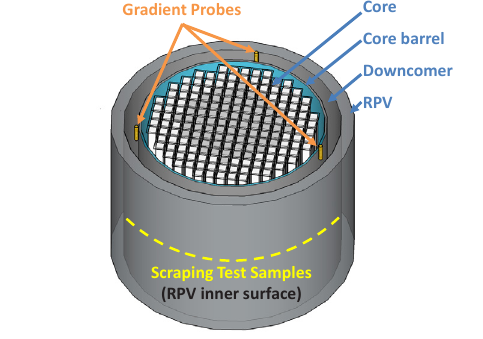
Figure 1. Simplified illustration on the Swiss PWR validation